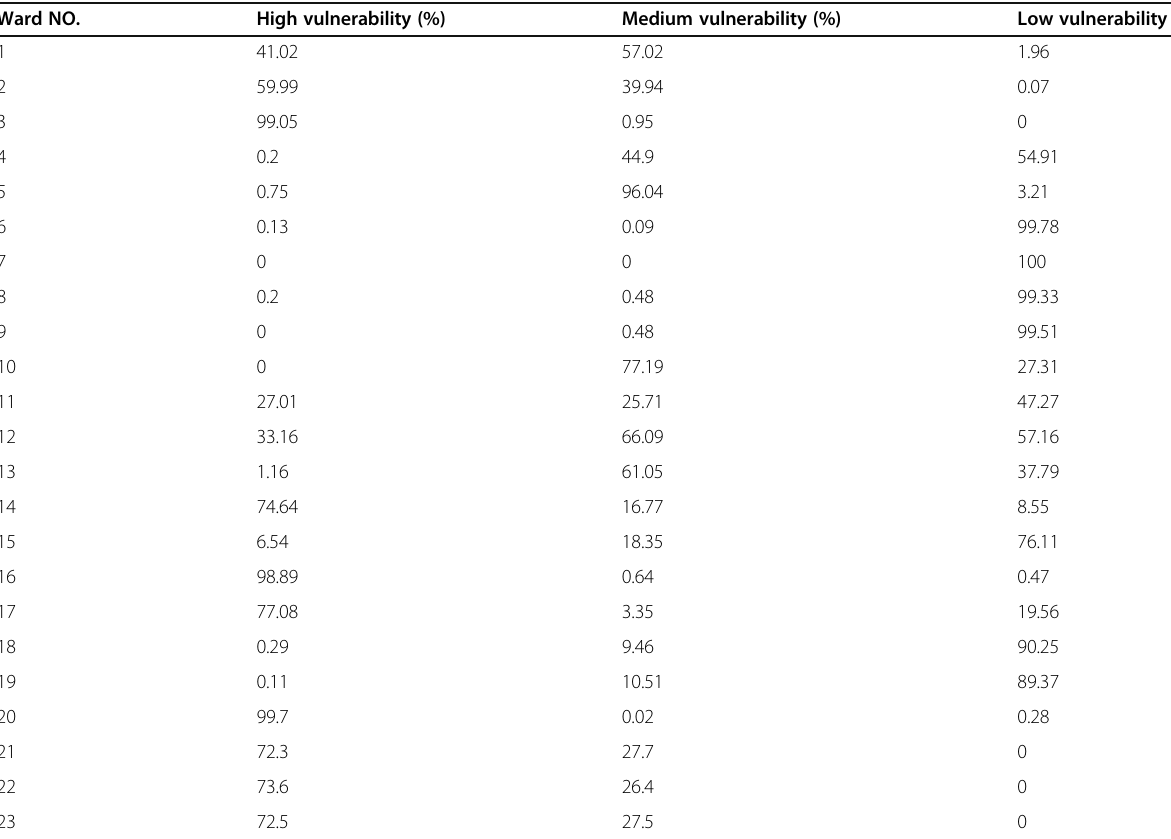
Table 3 Ward-wise distribution of socio-economic vulnerability for Aluva municipality Ward